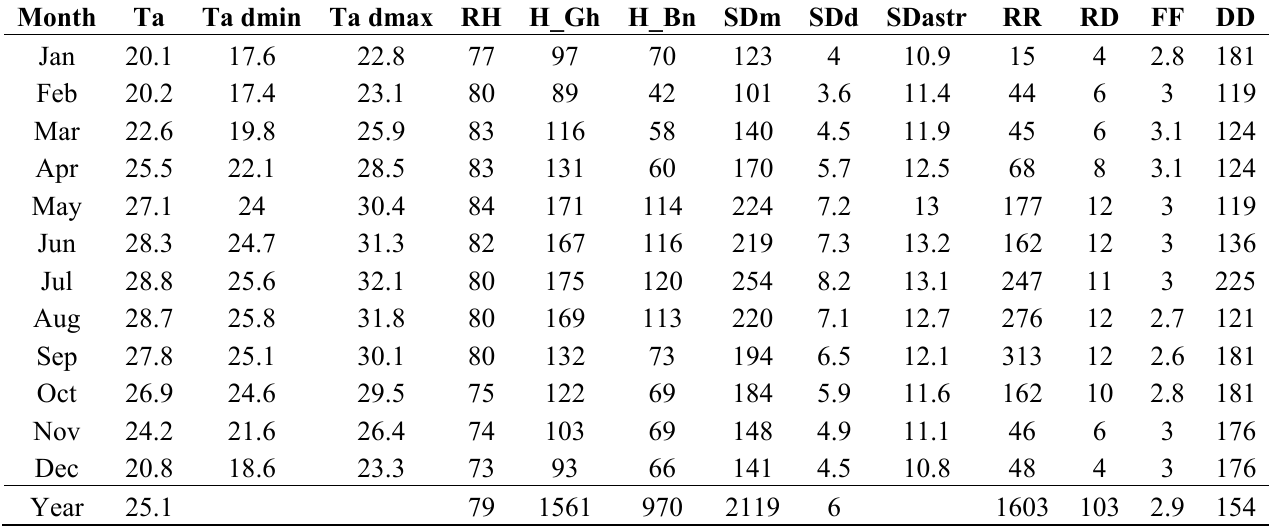
Table 5. Table of Haikou (20°N) Climate Data Summary (MeteonormV6.1 data period: